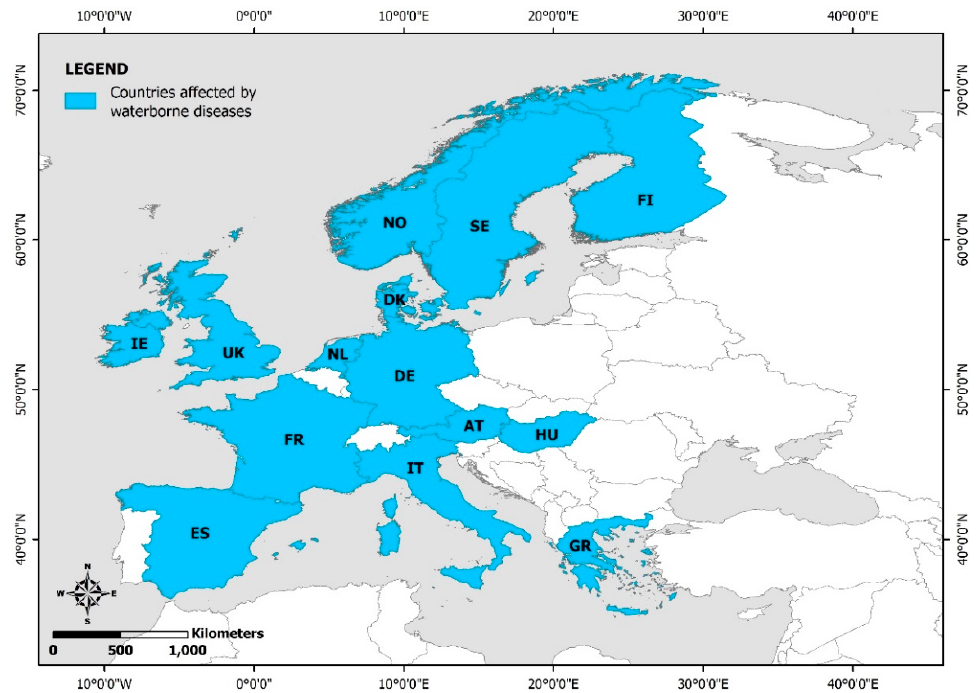
Figure 3. European countries with reported flood ‐ related waterborne diseases (NO: Norway; SE: Sweden; FI: Finland; DK: Denmark; NL: Netherlands; IE: Republic of Ireland; UK: United Kingdom; ES: Spain; FR: France; DE: Germany; AT: Austria; HU: Hungary; IT: Italy; GR: Greece). A case ‐ crossover study analyzed rainfall ‐ induced drinking water ‐ related outbreaks